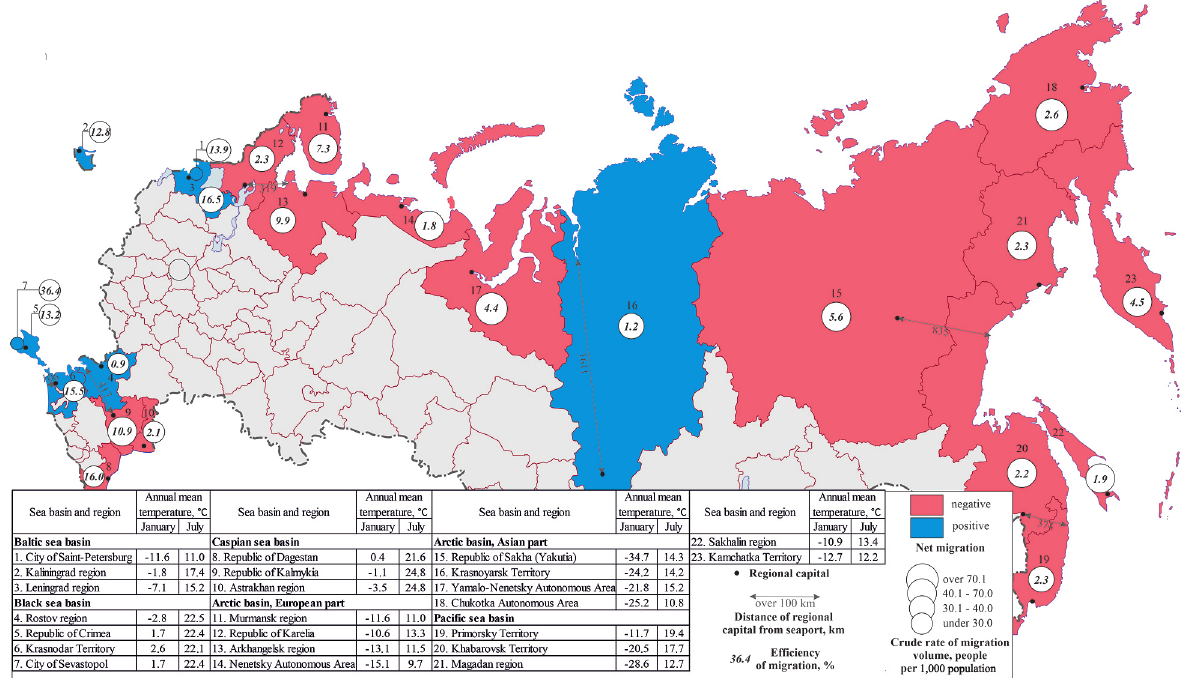
Fig. 1. The effectiveness of permanent migration in Russian coastal regions on average,